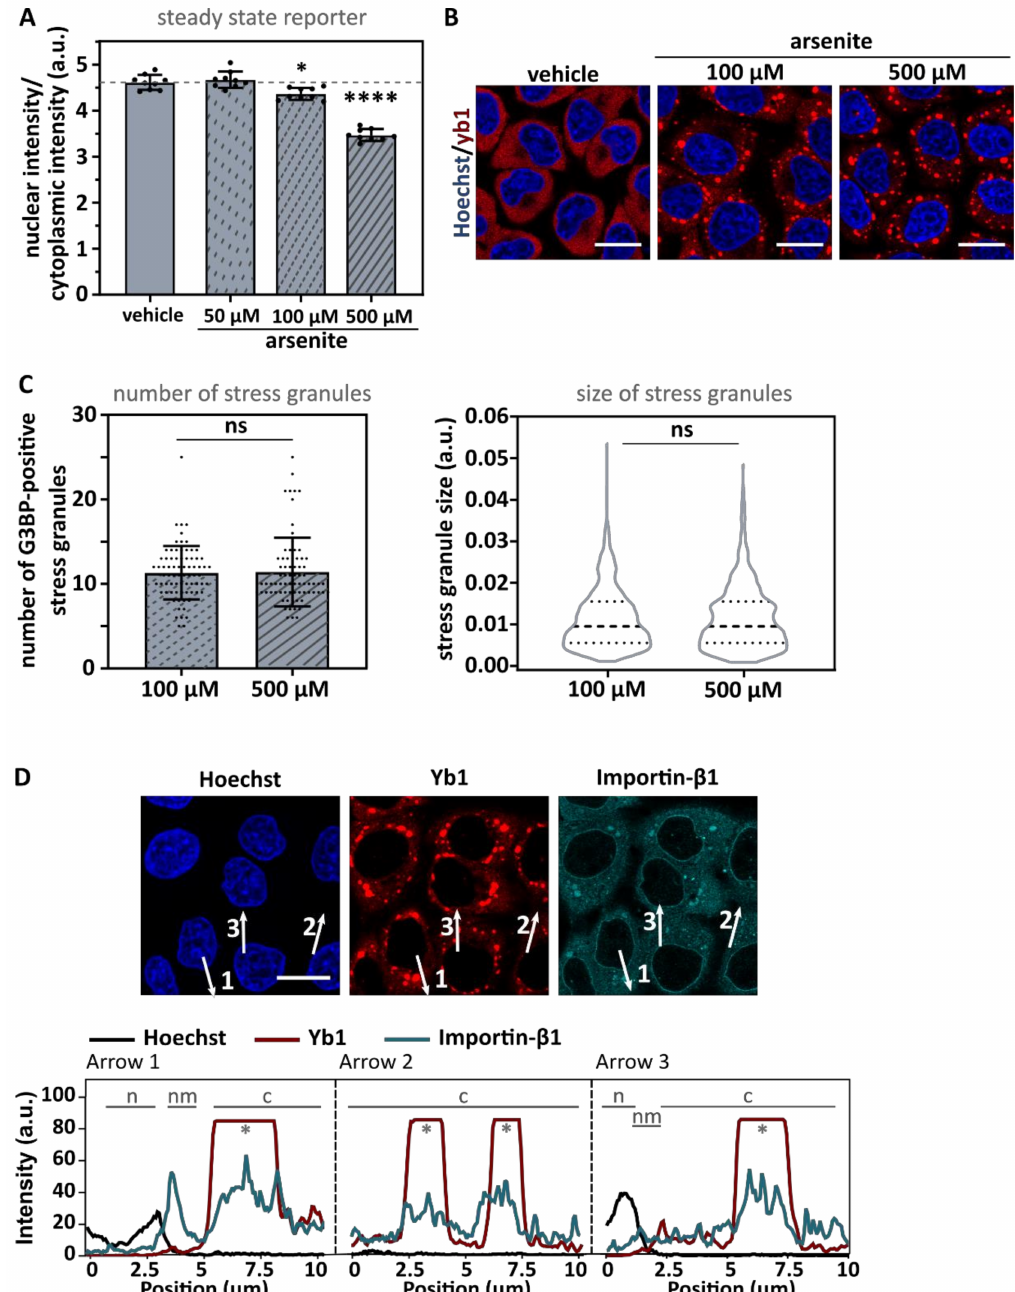
Figure 5. Dose-dependent arsenite nucleocytoplasmic transport deficits do not correlate with size and number of stress granules. ( A ). HeLa Kyoto cells expressing the reporter NLS c-myc -GFP 2x - NES ikb2 were treated with the indicated concentrations of arsenite before fixation. Nuclear and cytoplasmic intensity was automatically measured in three replicates (three wells per experiment with 100–2000 cells per well). Both 100 µ M and 500 µ M or arsenite resulted in a decreased nuclear intensity, with a stronger decrease in cells treated with 500 µ M. Mann–Whitney U test. Geometric means ± geometric SD. * indicates p < 0.05; **** indicates p < 0.001. ( B ). HeLa Kyoto cells treated with the indicated concentrations of arsenite and stained with anti-yb1 antibody. Scale bar = 20 µ m. ( C ). HeLa Kyoto cells were treated with the indicated concentrations of arsenite, fixed and stained with an anti-G3BP antibody. The number of G3BP-positive stress granules per cell (left graph) and size of G3BP-positive stress granules (right graph) were measured in ImageJ. No difference in the number of stress granules per cell or size of stress granules was observed. Left graph: each dot represents